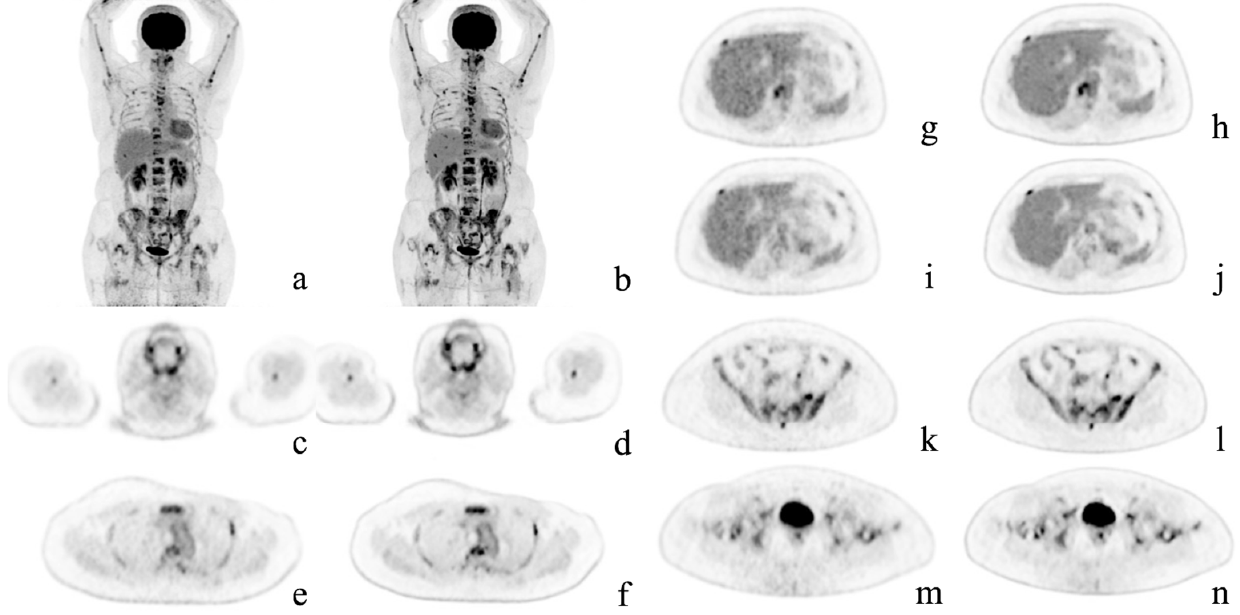
Figure 2. Representative case. A 54-year-old woman with multiple bone metastases to the spine, ribs, sternum, humerus, hipbone, and femur after surgery for left breast cancer. Maximum intensity projection and axial positron emission tomography images with conventional Gaussian filtering ( a , c , e , g , i , k , m ) and those obtained with deep learning reconstruction ( b , d , f , h , j , l , n ). AiCE (DLR) images show a reduction in noise, especially in the liver, and are easier to identify the metastases.